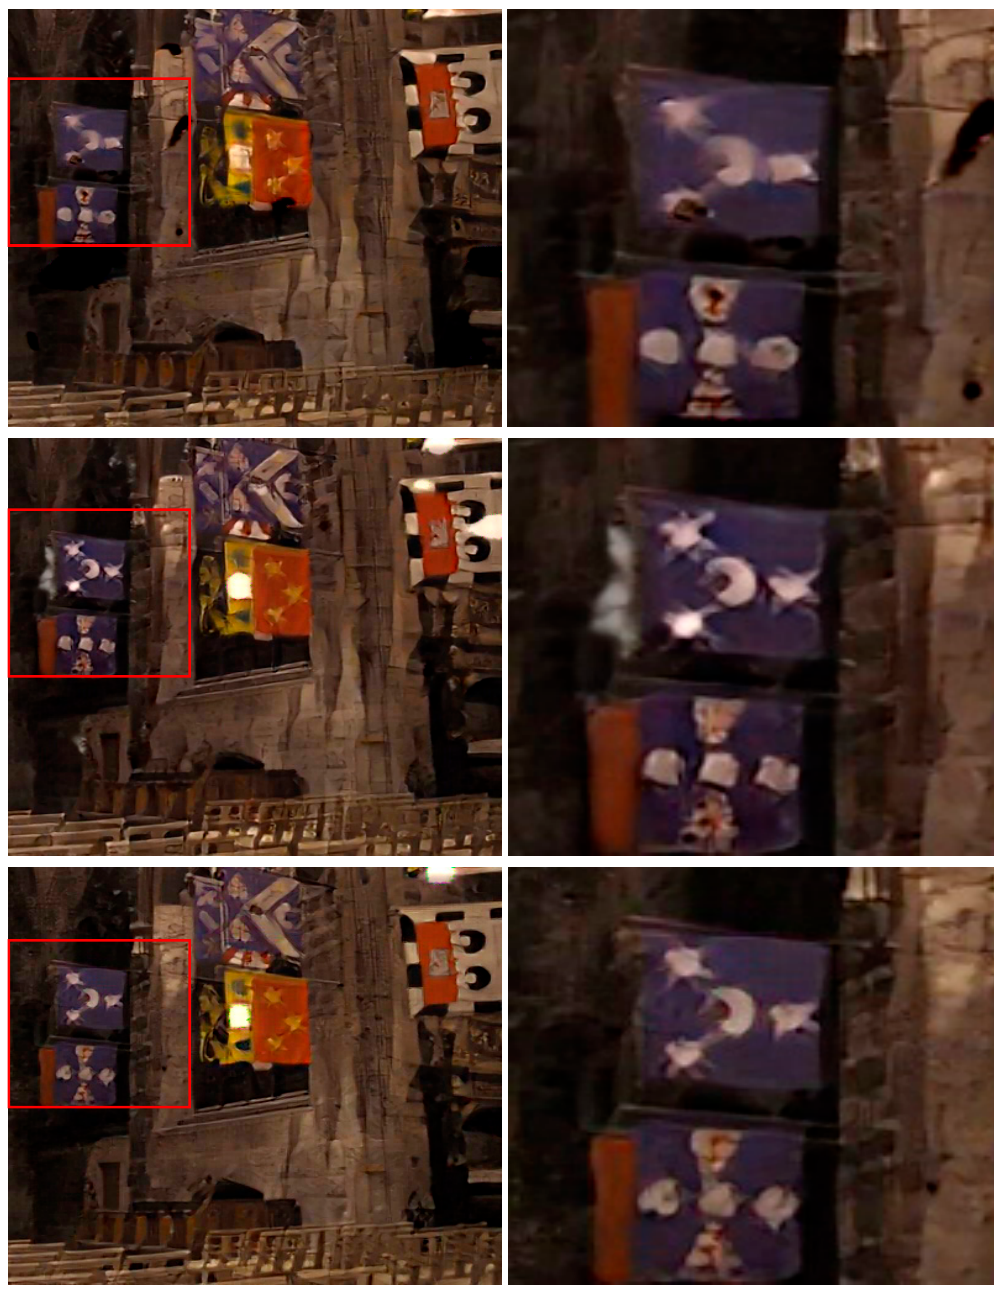
Figure 23. Generated images from extracting different layers in VGG16 on Kohler dataset. First row uses low layers, second row combines low layers and high layer, and last row uses high layers.